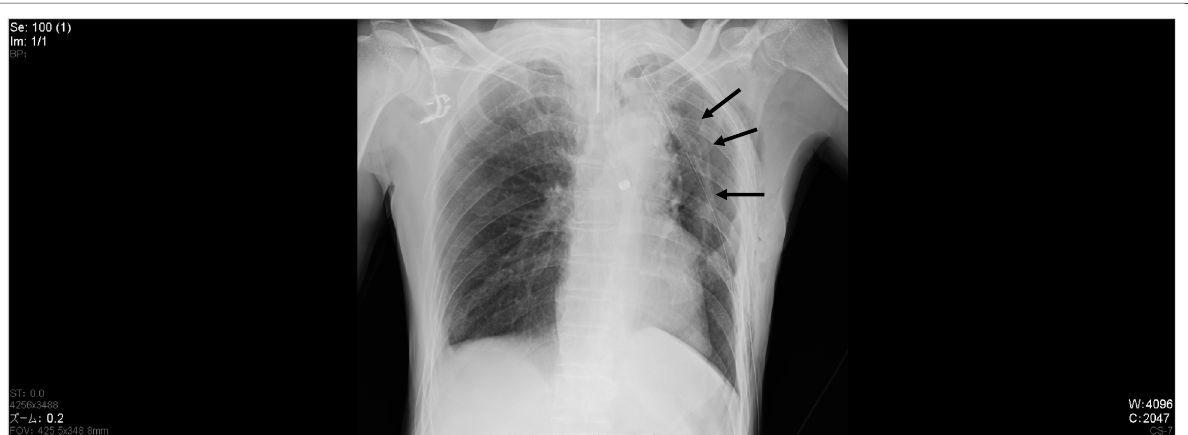
Fig. 1 Postoperative chest X-ray image. The volume of the left lung was reduced. The allows indicate the visceral pleura